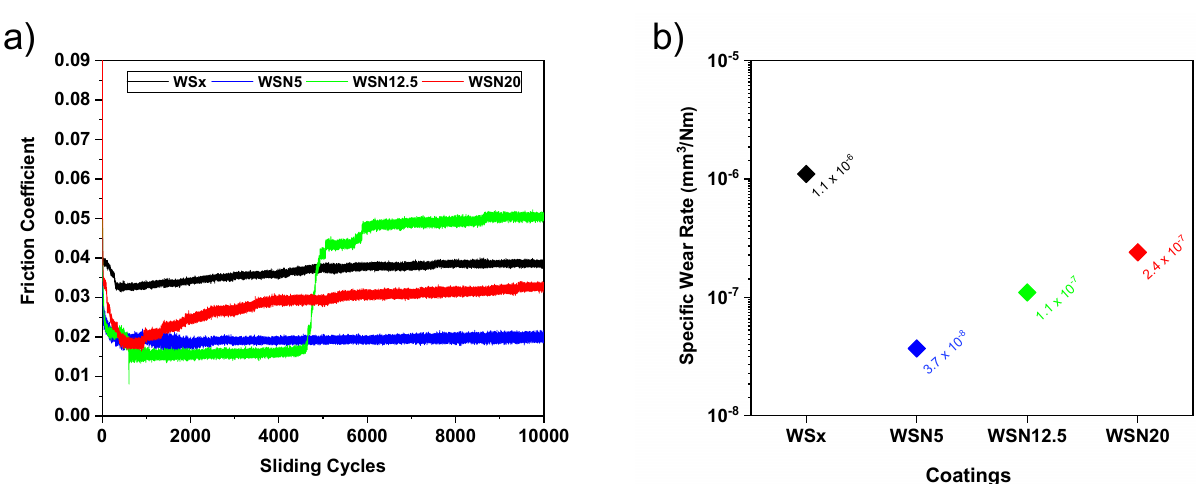
Figure 1. ( a ) Friction coefficient and ( b ) Specific wear rate of the coatings.